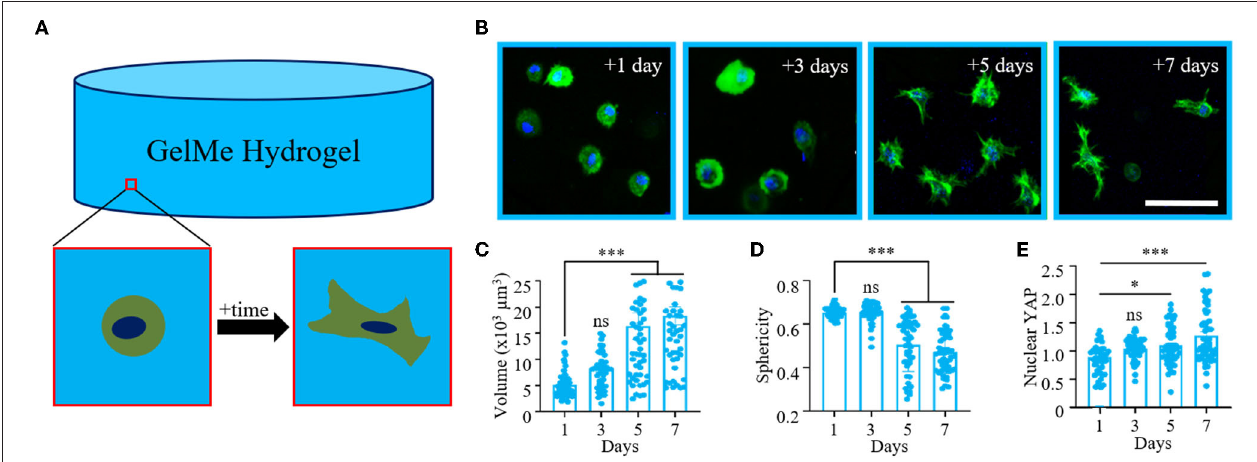
FIGURE 1 | Temporal changes in MSC morphology and YAP signaling in 3D GelMe hydrogels. (A) Schematic of a single MSC encapsulated in a GelMe hydrogel remodeling its local hydrogel environment over time. (B) Representative confocal images of MSCs (green, actin; blue, nuclei) encapsulated in GelMe hydrogels for 1, 3, 5, and 7 days. Quantification of cellular (C) Volume, (D) Sphericity, and (E) Nuclear YAP of MSCs encapsulated in GelMe hydrogels after 1, 3, 5, and 7 days in culture. Bar graphs represent the mean and points individual cells; n > 50 cells per group, ns, not significant, * p < 0.05, *** p < 0.001. Scale bar: 100 µ